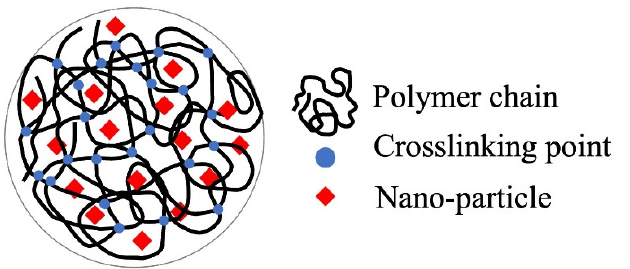
Figure 1. Hydrogel for the immobilization support and carrier.